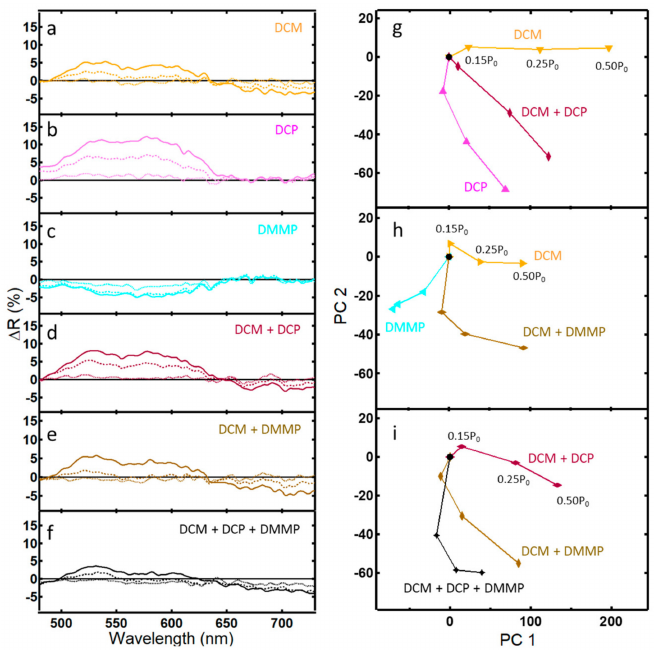
Figure 4. Di ff erential reflectance data ( ∆ R) and corresponding PCA plots for light reflected from the PhC within wing scales of the Morpho didius butterfly: ( a – f ) ∆ R after 5 min of exposure to the indicated vapor at concentrations 0.15 P 0 ( ··· ), 0.25 P 0 (–), and 0.50 P 0 (—); ( g ) PCA scores plot of a binary vapor mixture of DCM and DCP that captures 84.9% of the variance (PC 1 = 72.9%); ( h ) PCA scores plot of a binary vapor mixture of DCM and DMMP that captures 80.9% of the variance (PC1 = 73.2%); ( i ) PCA scores plot of a tertiary vapor mixture of DCM, DCP, and DMMP that captures 78.9% of the variance (PC 1 = 58.8%).